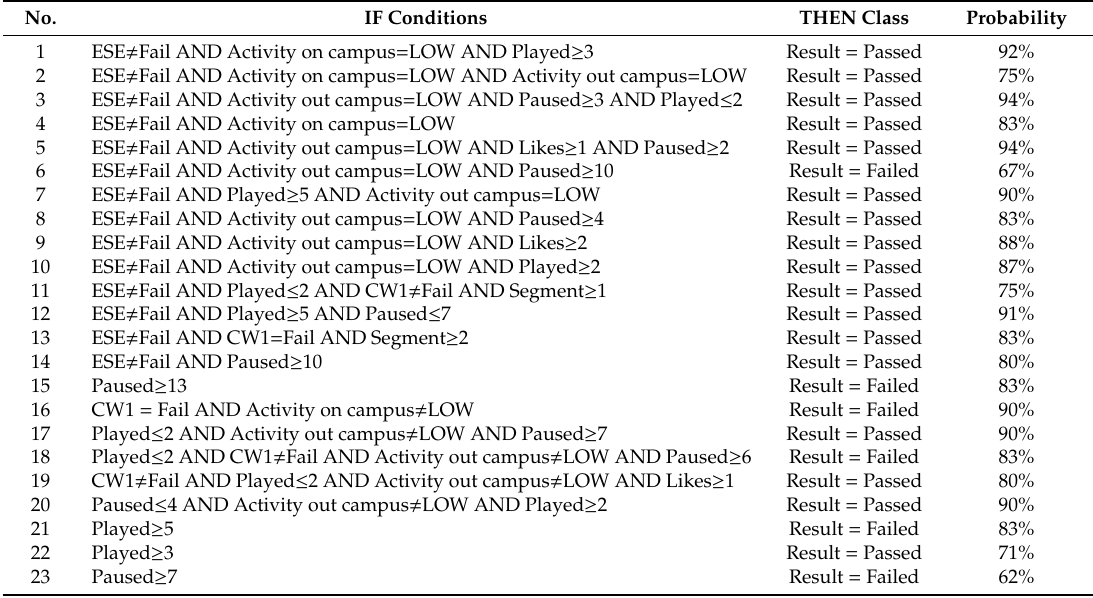
Table 11. Rules set by